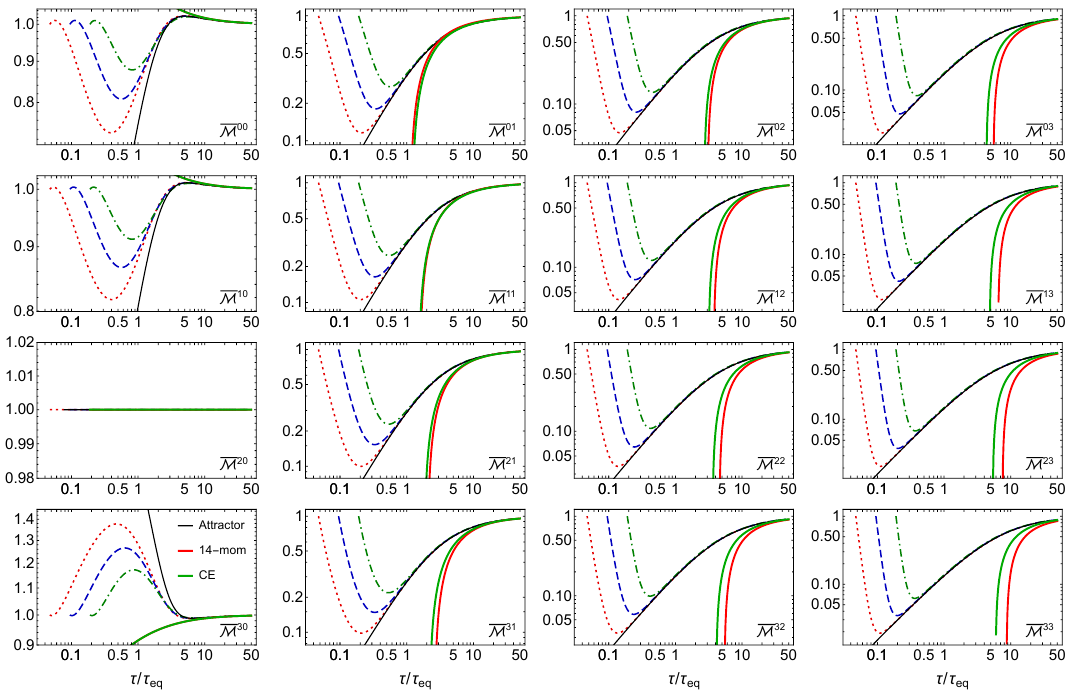
Figure 5 . Scaled moments M nl as a function of rescaled time for the case m = 1 GeV. Initial conditions and line styles are the same as in figure